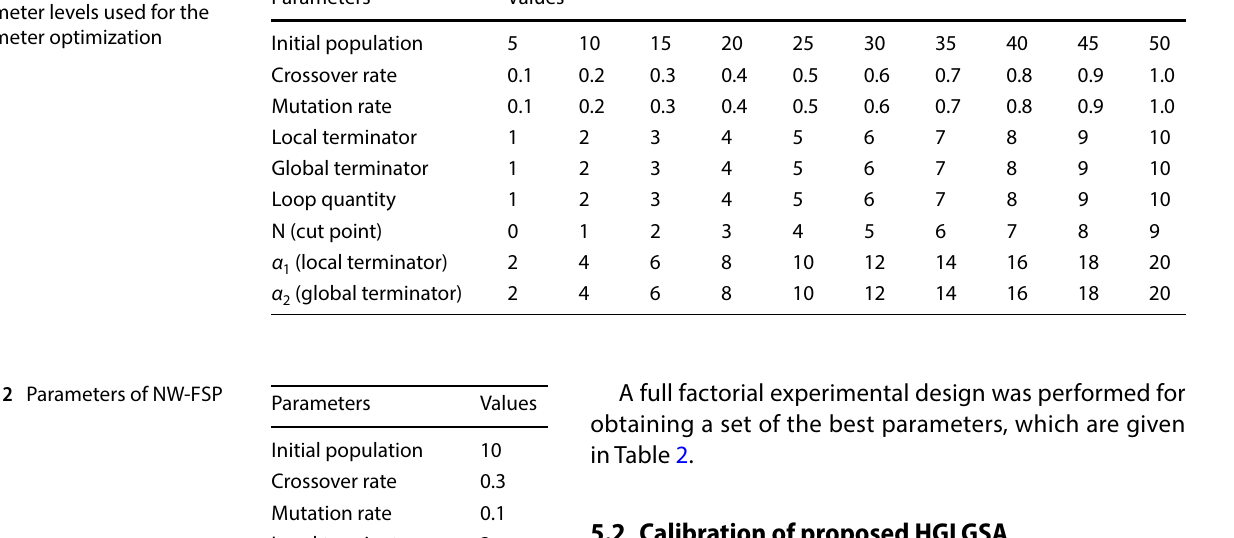
Table 1 The SRMOHGA’s parameter levels used for the parameter optimization